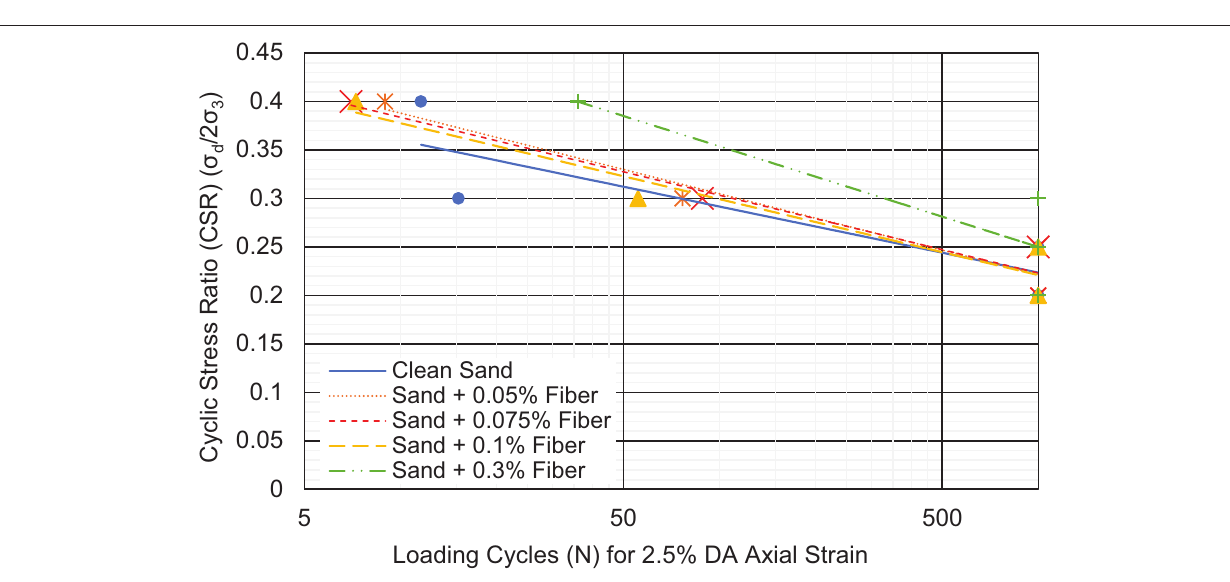
to trigger 2.5% DA strain at 50 loading cycles in clean sands, and sands containing 0.05, 0.075, 0.1, and 0.3%